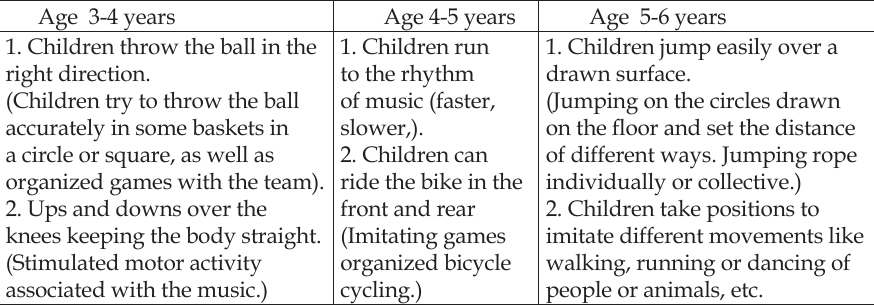
Table 5. Standard 3: Development of motor coordinating